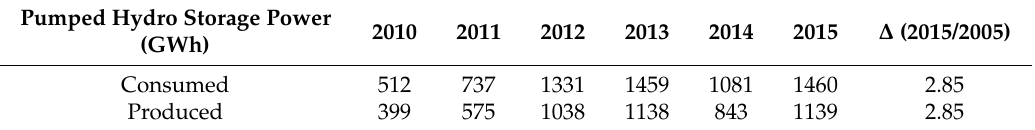
Table 9. Pumped hydro storage power consumption and production (GWh) (calculations based on data taken from